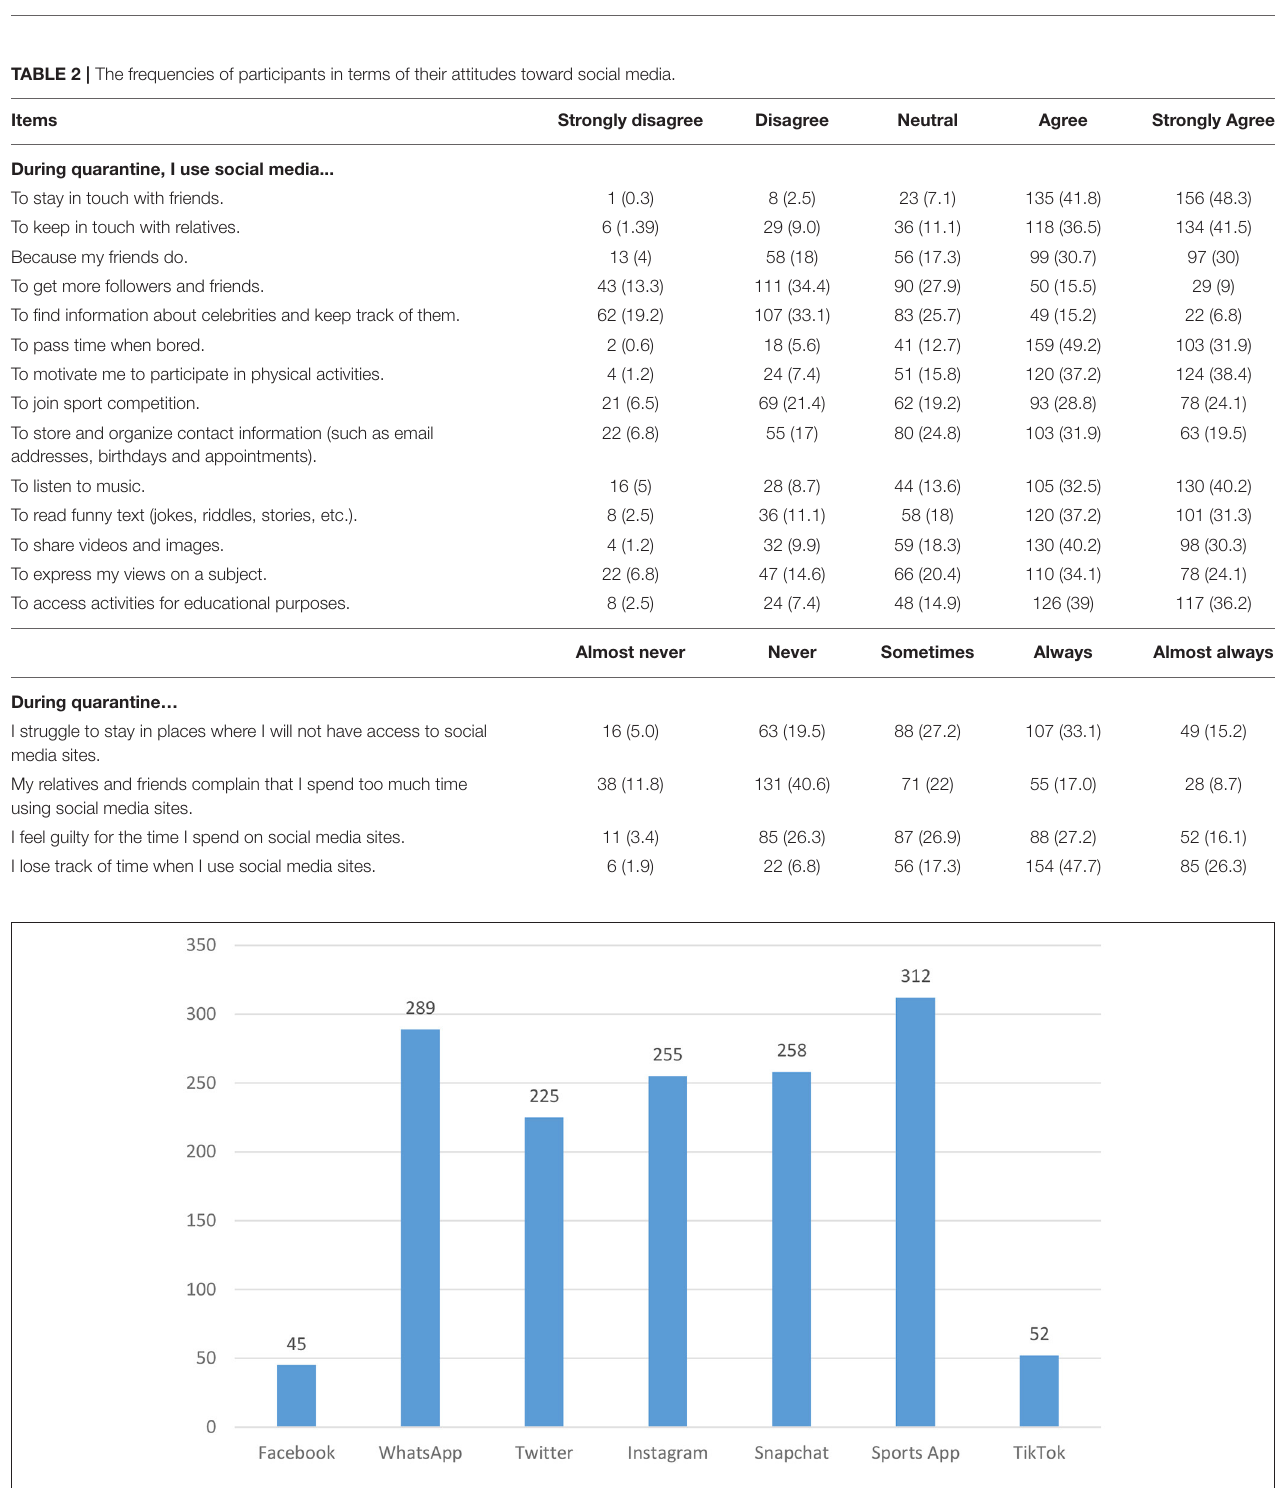
FIGURE 1 | Social media application used by the